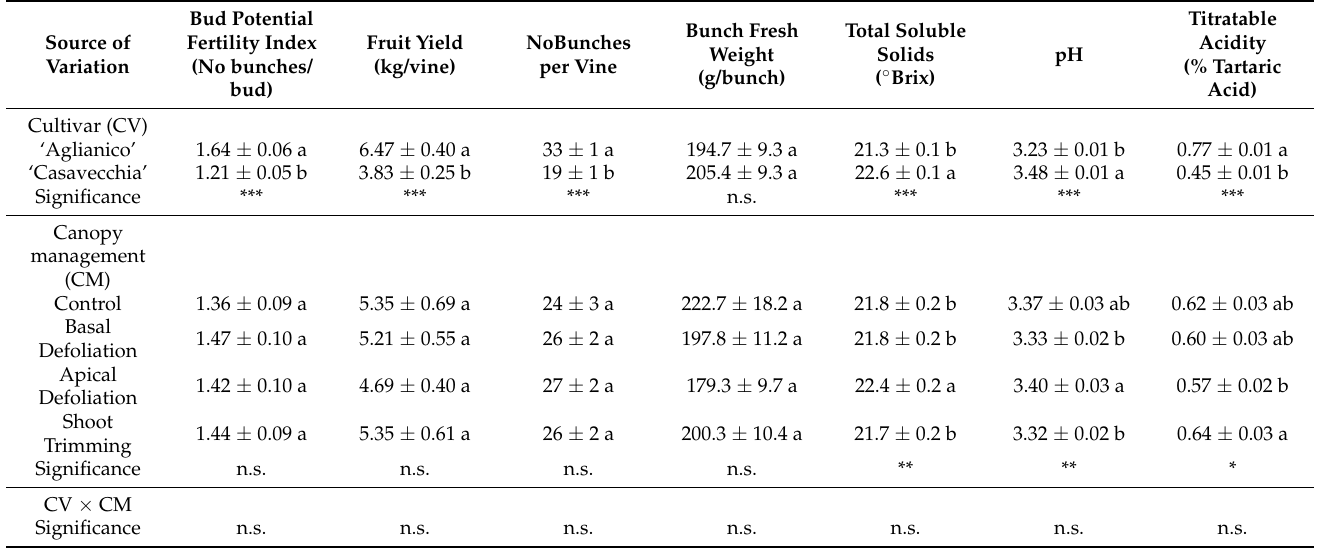
Figure 3. Fruit set in ‘Aglianico’ and ‘Casavecchia’ grapevines exposed to four canopy management treatments (CTRL: control; BD: basal defoliation; AD: apical defoliation; TRIM: shoot trimming). Vertical bars indicate standard errors of the means. Separately for the cultivars, different letters indicate significant differences between canopy management treatments according to the Tukey test ( p ≤ 0.05). Table 3. Effect of the cultivar (CV: ‘Aglianico’ and ‘Casavecchia’), canopy management (CM: control, basal defoliation, apical defoliation, shoot trimming) and the CV × CM interaction (assessed by two- way ANOVA) on bud potential fertility index, fruit yield, number of bunches per vine, bunch fresh weight, and berry juice total soluble solids, pH, and titratable acidity at harvest. N.s., *, **, and ***: not significant, or significant at p ≤ 0.05, 0.01, and 0.001, respectively. Separately for each source of variation and within each column, means followed by different letters are significantly different according to the Tukey test ( p ≤